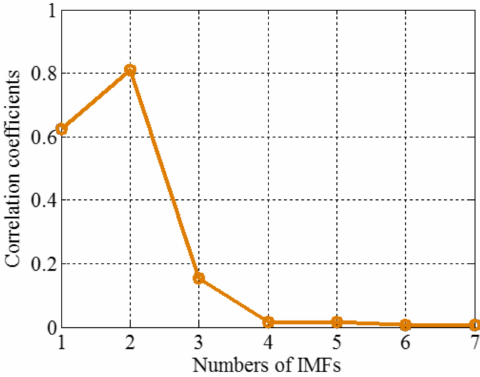
Figure 2. The coefficients of correlation different IMFs and the sample signal.